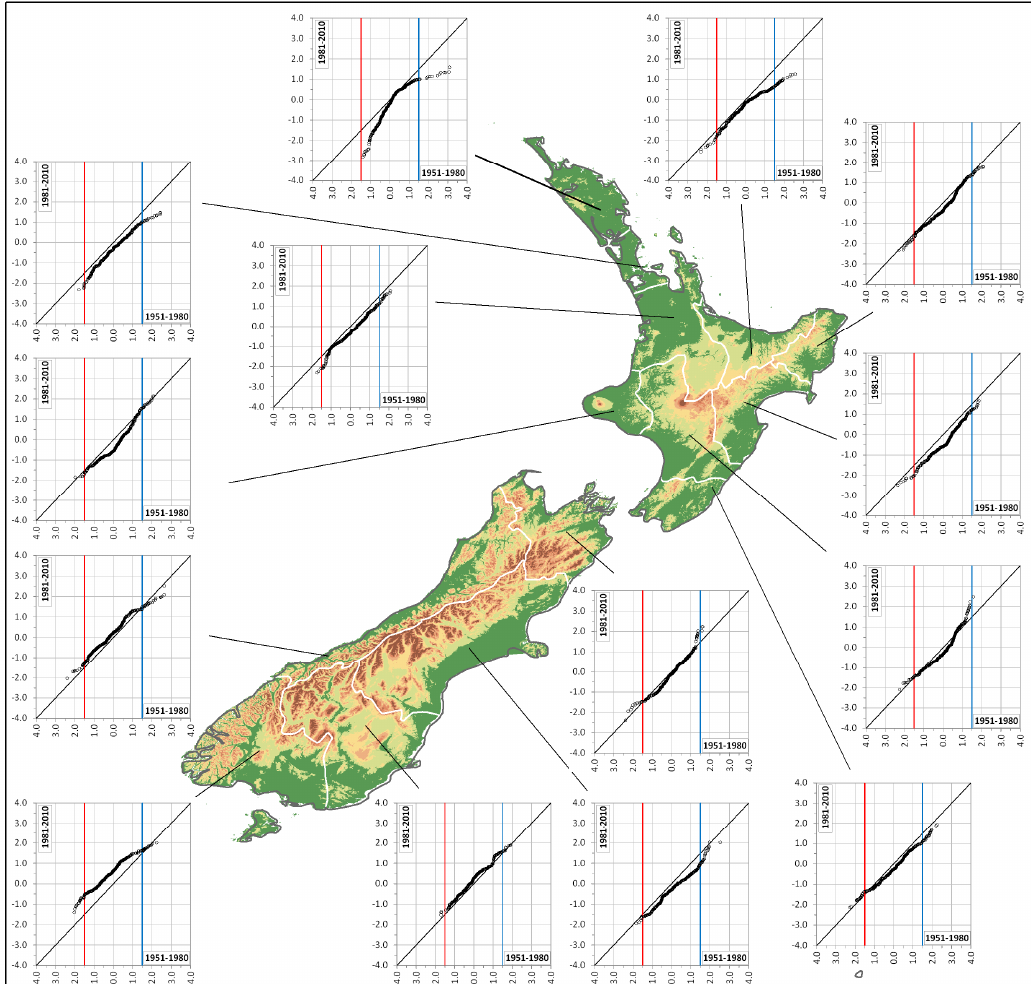
Figure 6. Regional results of the ITA method applied to the 12-month SPI.